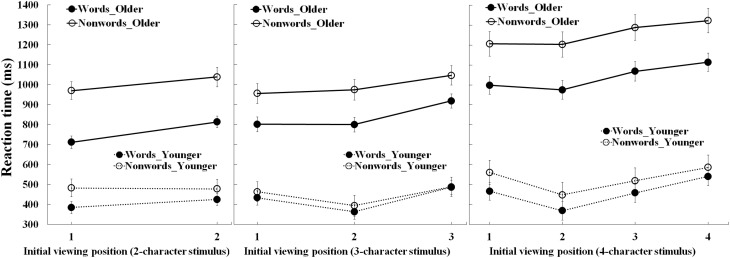
Lexical decision times for the older and young adults as a function of the initial viewing position and stimulus type. Bars correspond to standard errors.